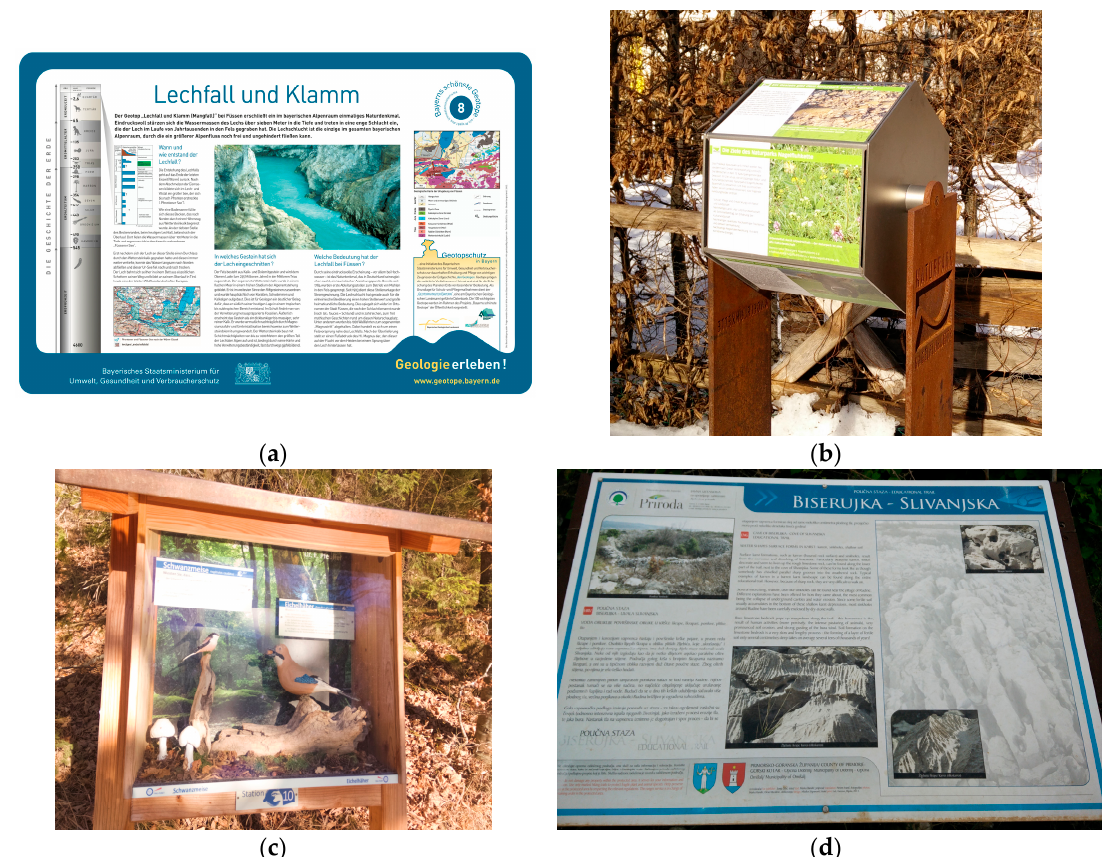
Figure 2. Various interpretive signage: ( a ) Lech Waterfall and Gorge sign from Bavaria’s Most Beautiful Geosites series [25] (a direct link to sign can be accessed here (in German): https://www.lfu.bayern.de/geologie/geotope_schoensten/8/doc/8_schautafel.pdf); ( b ) three-dimensional sign in Oberstaufen, Bavaria; ( c ) multimedia diorama at Lake Alat, Füssen, Bavaria; ( d ) panel about karst features at Biserujka-Slivanjska Cave in Rudine, Croatia (Krk Island). Photos: Sonja Prendivoj.